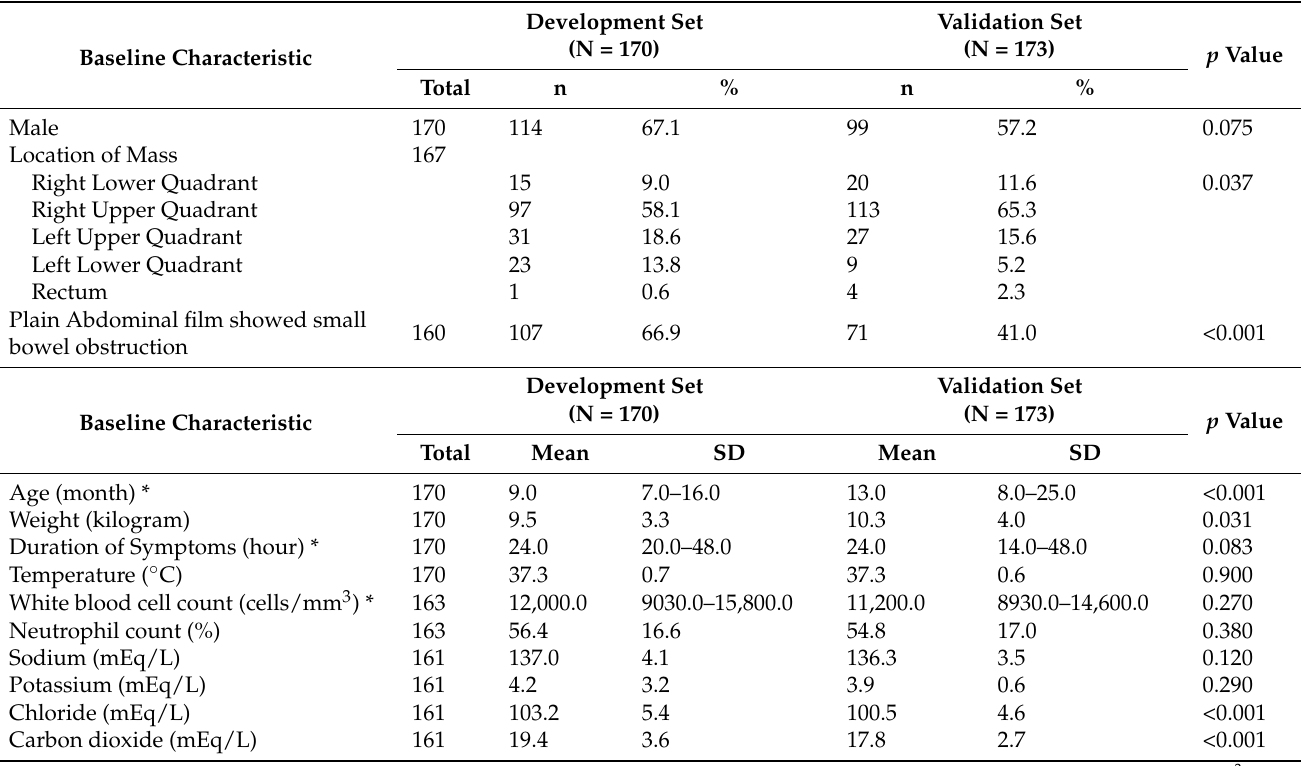
Table 2. Baseline characteristics between development set (N = 170) (Showing missing data) and validation set (N = 173) of intussusception patients.